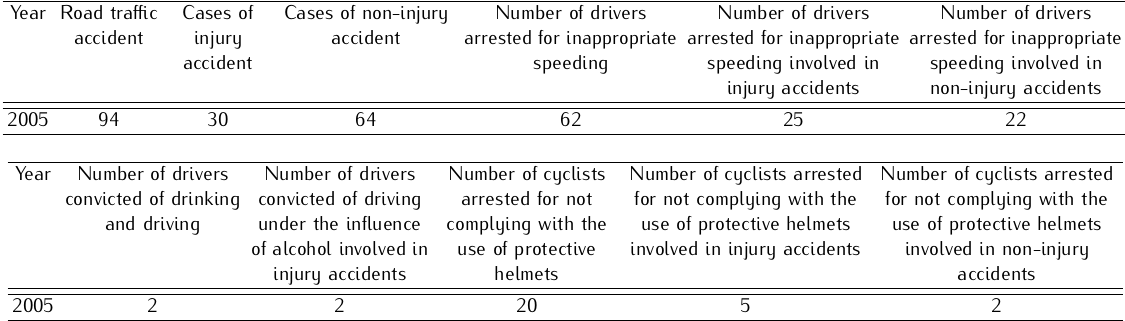
Table 3. Road Accident Data and associated safety problems.